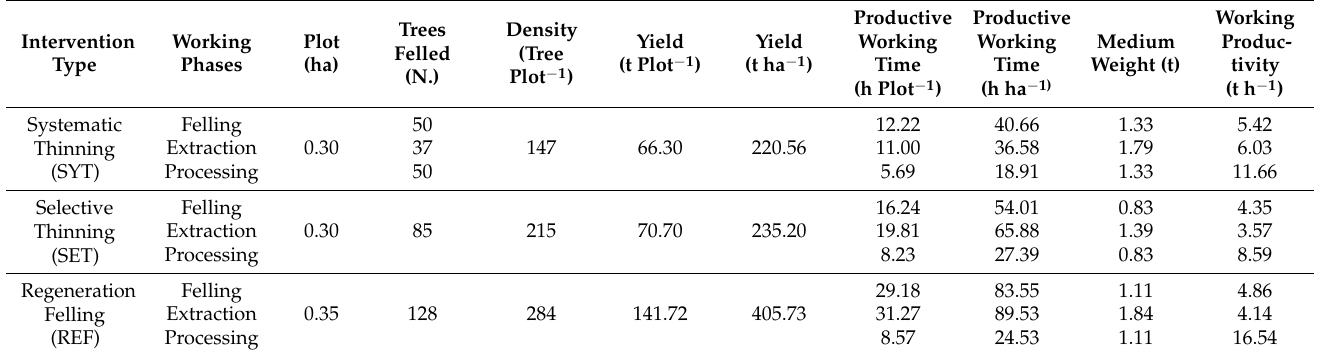
Table 3. Wood production, working times, and productivity of the forest yard in the three